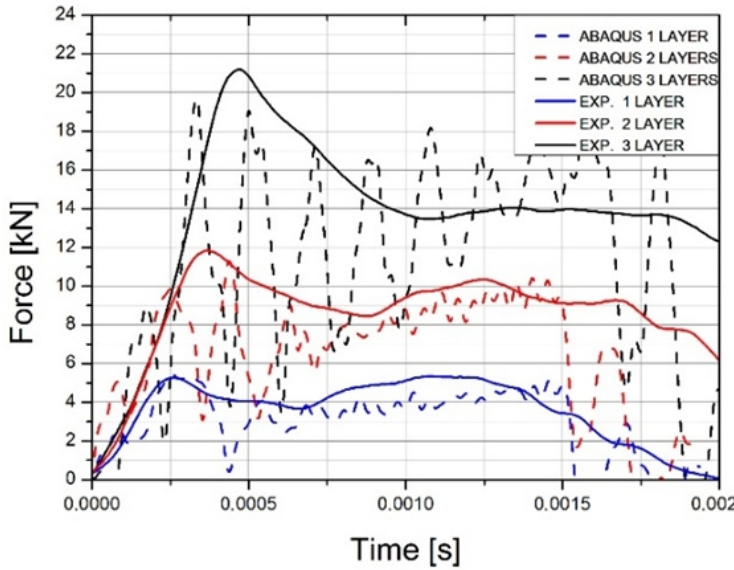
Figure 30. Comparison of force at damage initiation for carried out experiments and simulations.